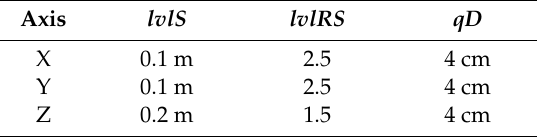
Table 1. Detection parameter for all coordinate axes.